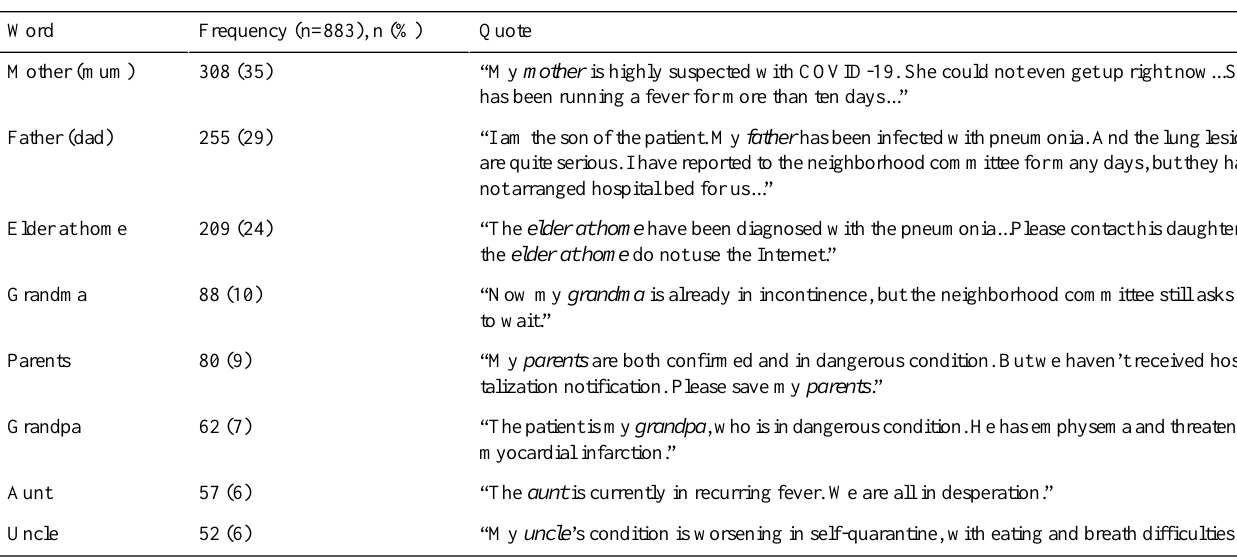
Table 2. Document frequency of names of family